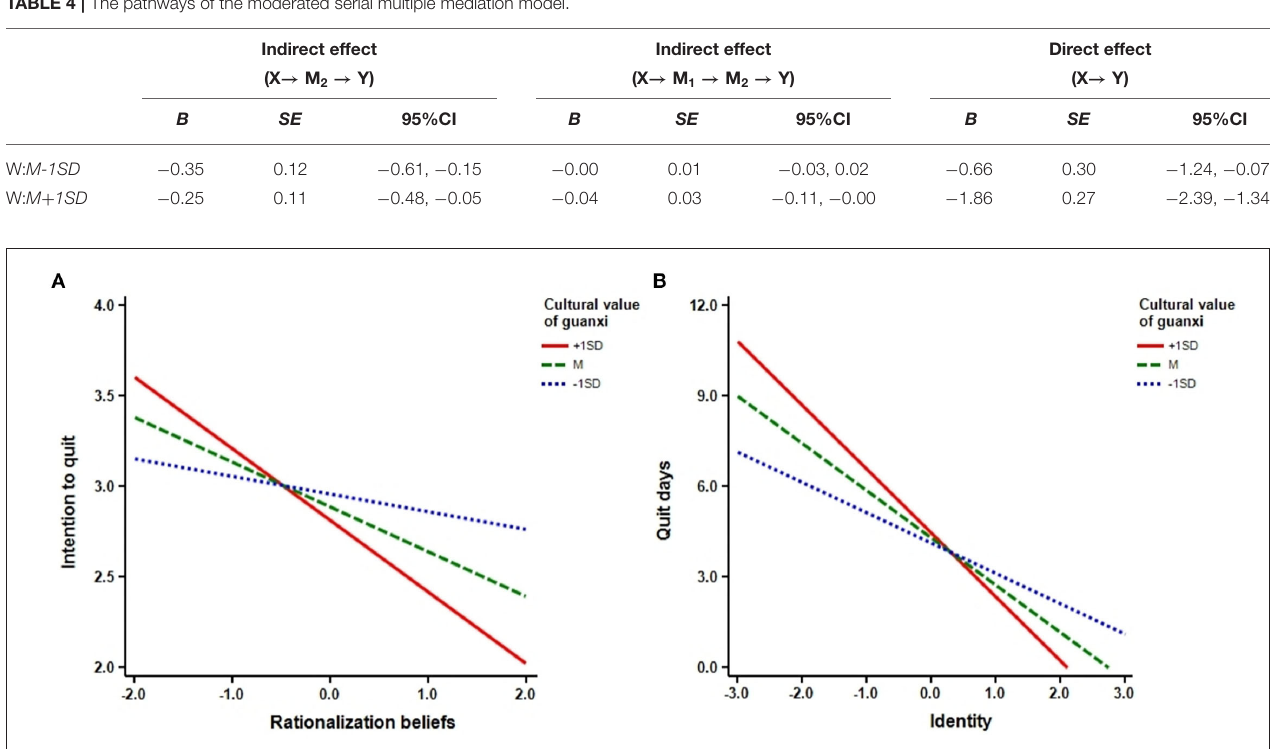
FIGURE 2 | (A,B) Simple slope